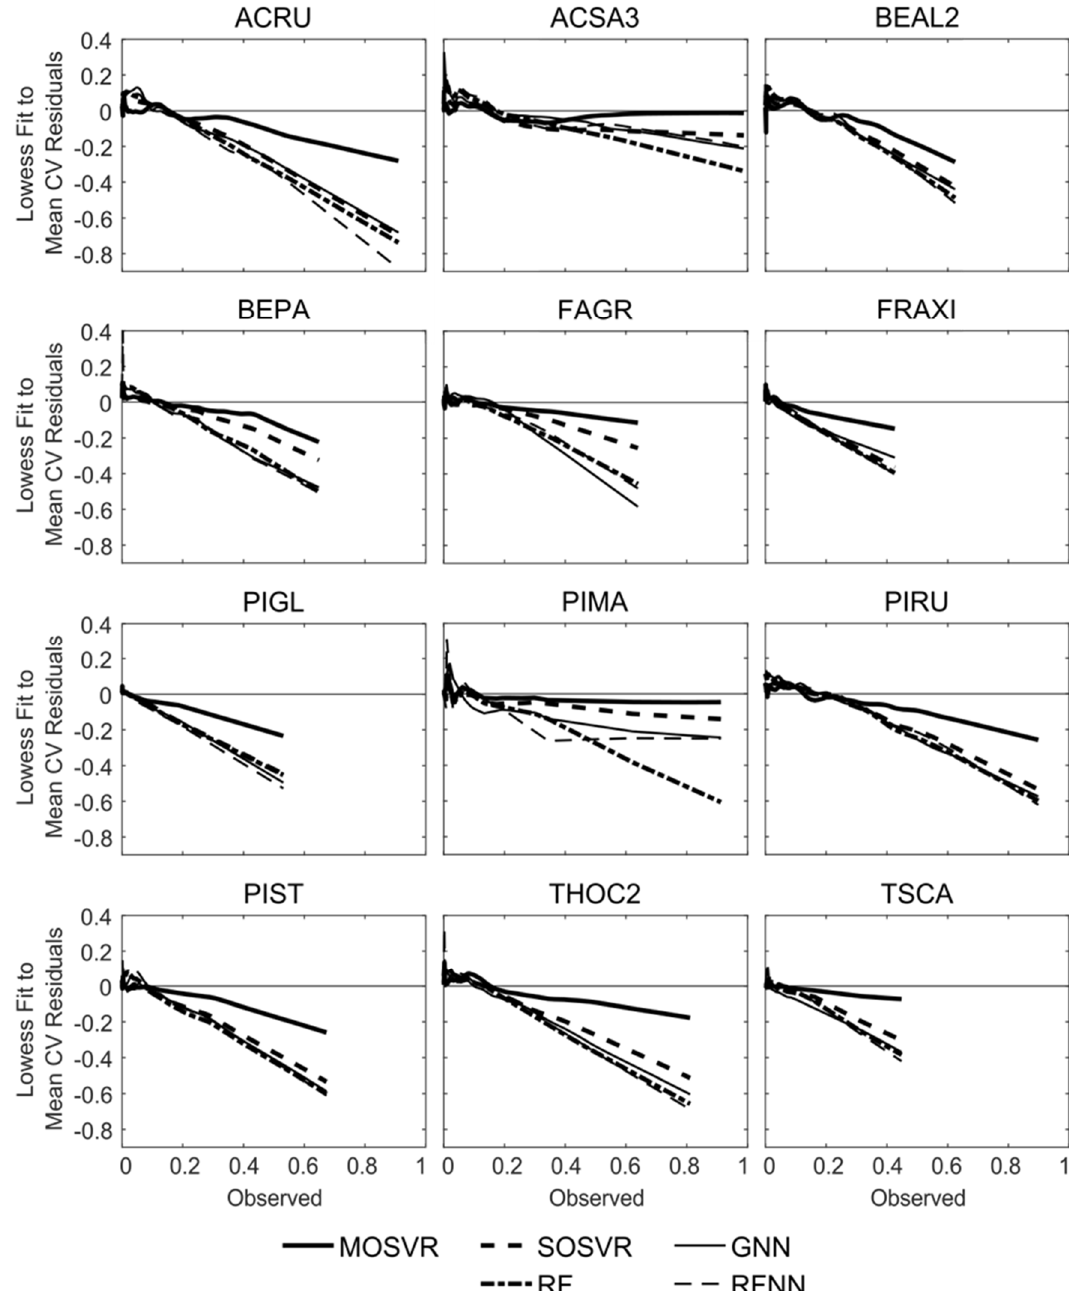
Figure 7. Trends in residual values for selected model types fit to individual tree species. Lowess curves fit to residual plots (demonstrated in Figure 6) for each of five model types and 12 individual species. Lowess curves for species ABBA are provided in Figure 6f.